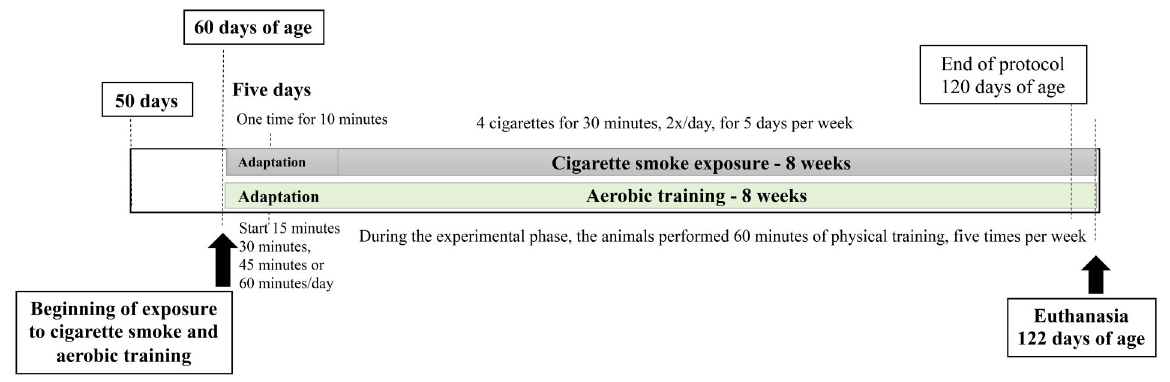
Figure 1. Timeline of experimental design during the aerobic training and cigarette smoke